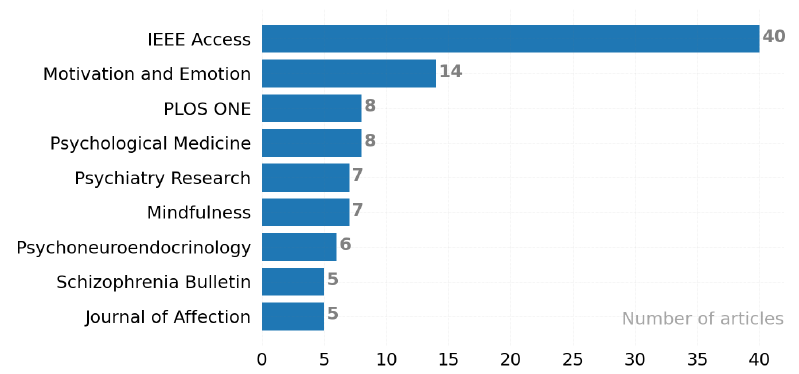
Figure 15. The ten most preferred journal titles.